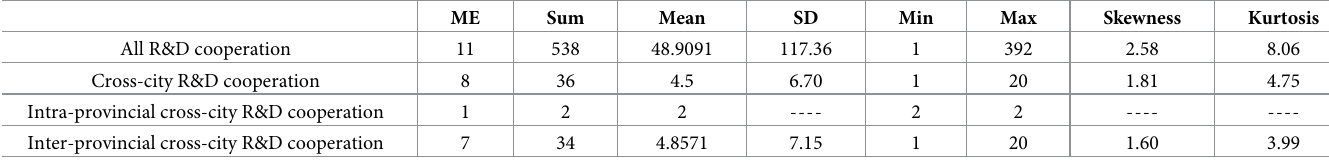
Table 6. Descriptive statistics of Beijing-Tianjin-Hebei region